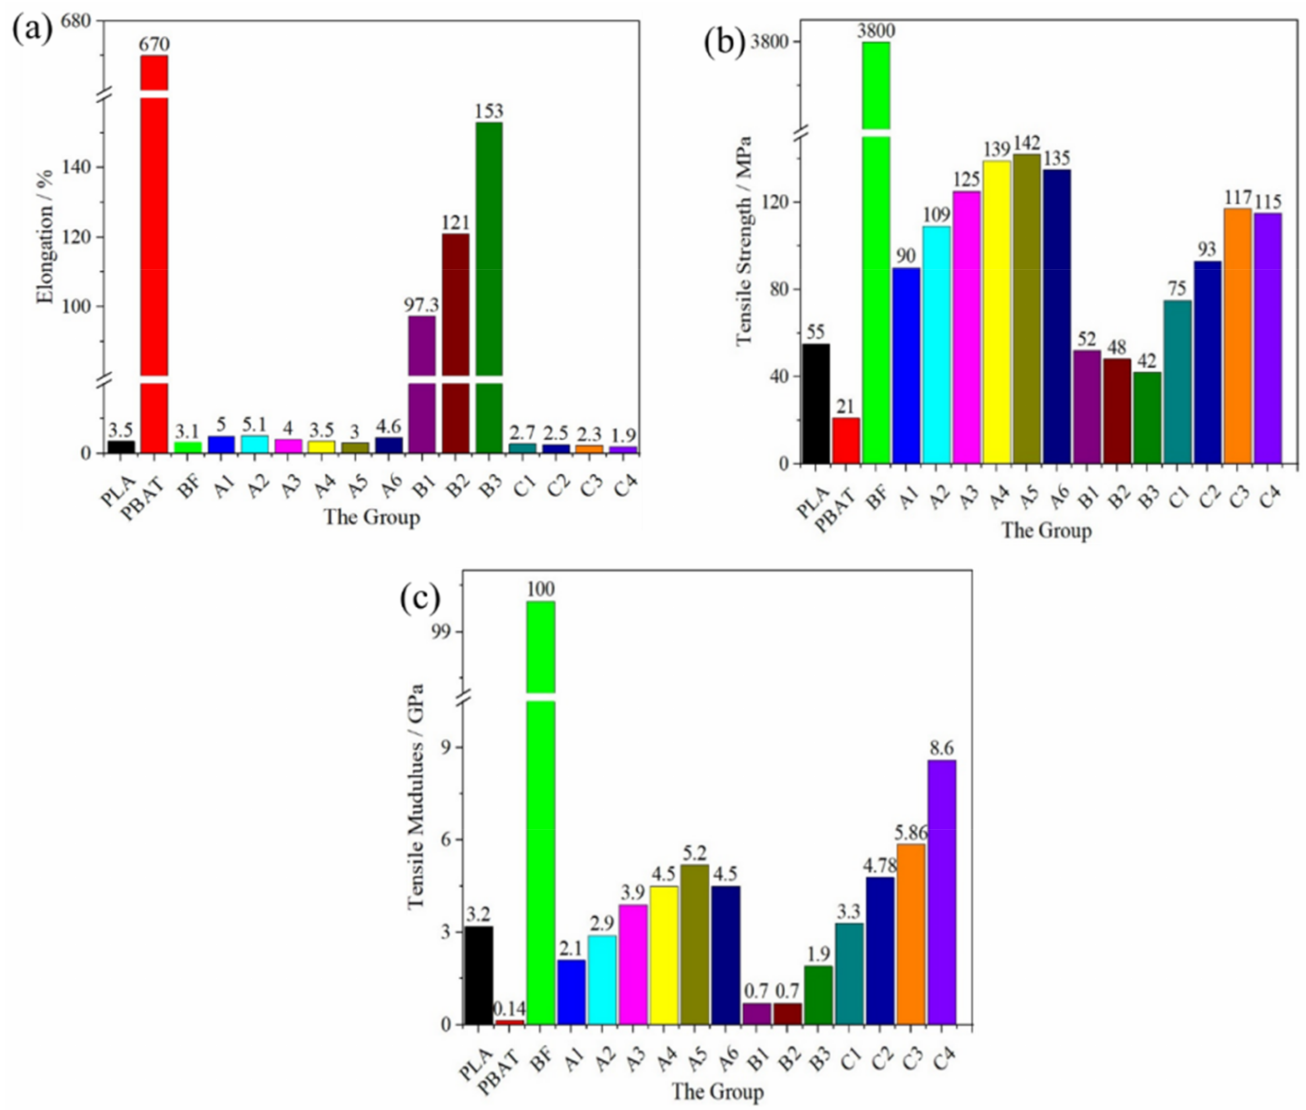
Figure 6. The mechanical properties of the polymers with a focus on the tensile properties: ( a ) elon- gation at break, ( b ) tensile strength, and ( c ) tensile